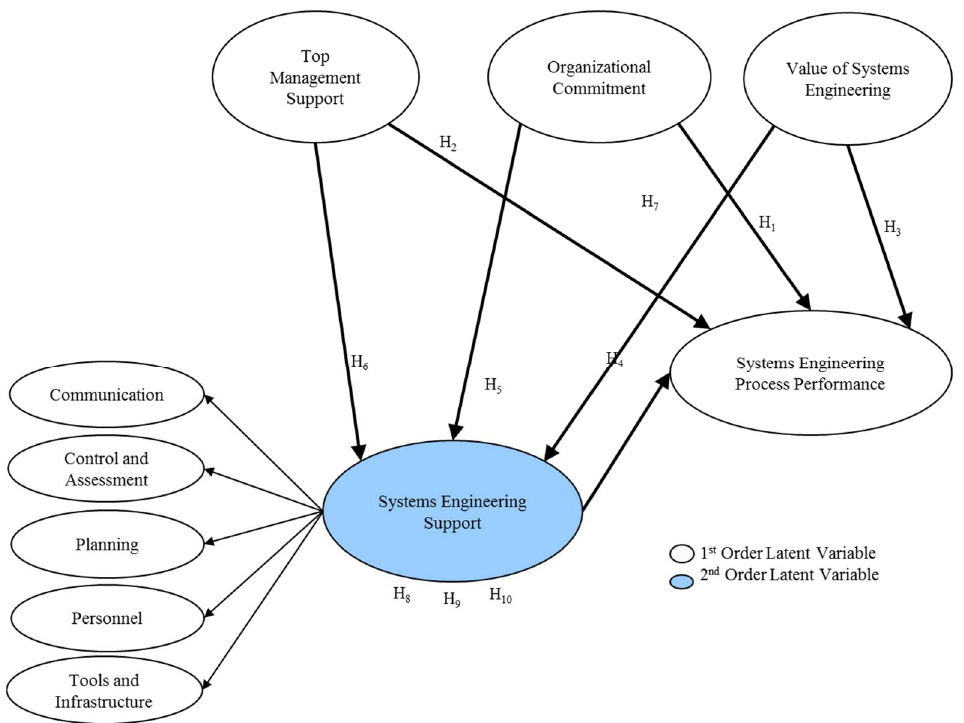
Figure 1. The hypothesized conceptual model.